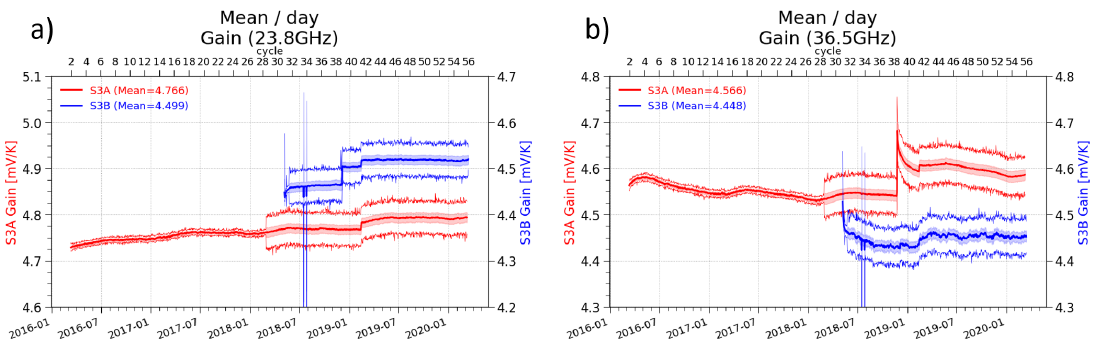
Figure 10. Receiver gain for S3A (red) and S3B (blue). Bold lines show the average, shades the standard deviation and lighter lines are minimum/maximum values. ( a ) 23.8 GHz channel ( b ) 36.5 GHz